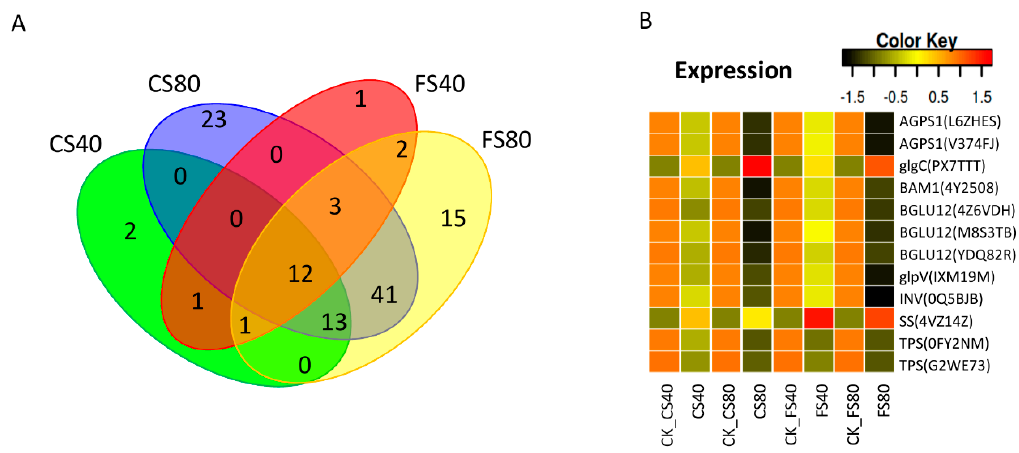
Figure 8. Shade induced common DEGs in starch and sucrose metabolism and their expression patterns. ( A ). Venn graph showing the common and specific DEGs induced by shade stresses. ( B ). The expression levels of DEGs in starch and sucrose metabolism. The expression level was calculated as fragment per kilobase per million reads (FPKM) from RNA-Seq data. The color in heatmap represents the z-score after the transformation of log2(mean FPKM). Each row in the heatmap represents the levels of a DEG under different conditions. DEG’s name and gene ID in parenthesis were listed on the right side of the heatmap. The abbreviation of each DEG is given in Table 5. FS40, FS80, CS40, and CS80 represent shade treatments of 40% shade at the flowering stage for 30 days, 80% shade at the flowering stage for 30 days, 40% shade from the seeding stage for 30 days to the flowering stage for another 30 days, 80% shade from the seeding stage for 30 days to the flowering stage for another 30 days, respectively. Three experiments were conducted, each with three plants. CK represents the control under natural sunlight.